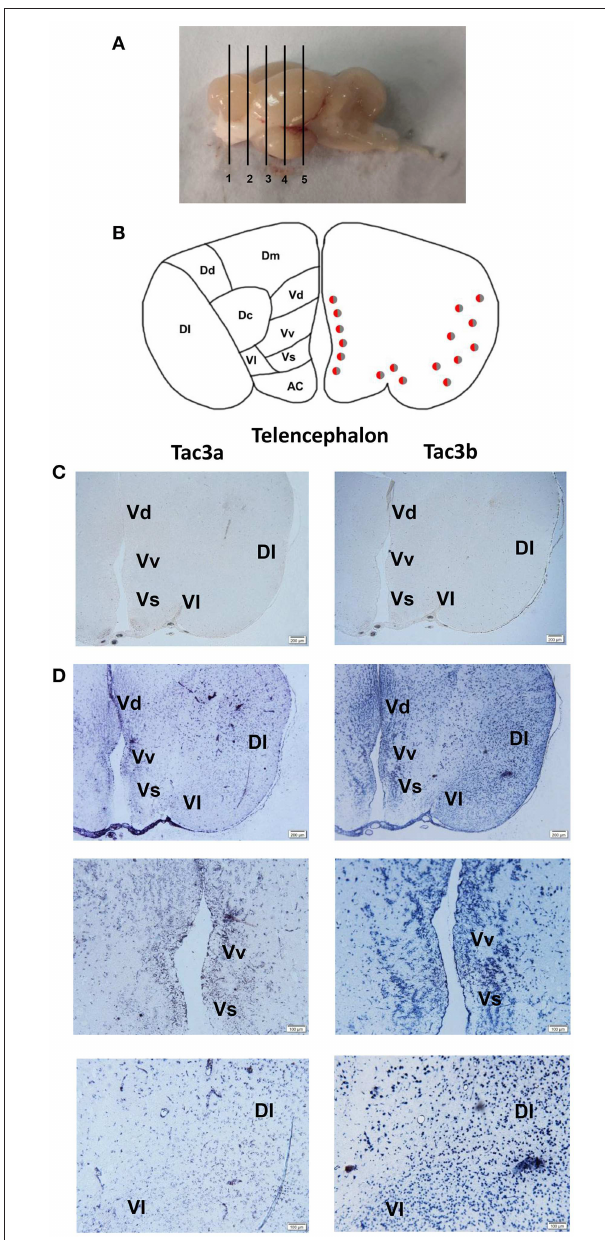
FIGURE 6 | Photomicrographs and schematic illustrations of the mRNA levels of tac3s in the brain of the spotted sea bass, as detected by in situ hybridization (ISH). Schematic illustrations showing the positions of the slides within the brain (A) . Schematic drawings of spotted sea bass telencephalon (B) . Photomicrographs of tac3a and tac3b sense probe results in the telencephalon (C) . Positive signal of tac3a and tac3b in the telencephalon (D) . VM, ventromedial thalamic nucleus; Vv, area ventralis telencephali pars ventralis; Vs, area ventralis telencephali pars supracommissuralis; Vd, Area ventralis telencephali pars dorsalis; Dl, area dorsalis telencephali pars lateralis; Vl, area ventralis telencephali pars lateralis; Dm, area dorsalis telencephali pars medialis; Dc, area dorsalis telencephali pars centralis; Dd, area dorsalis telencephali pars dorsalis; AC, anterior commissure; Vd, area ventralis telencephali pars dorsalis. Red and gray dots represent the locations of tac3a and tac3b , respectively.